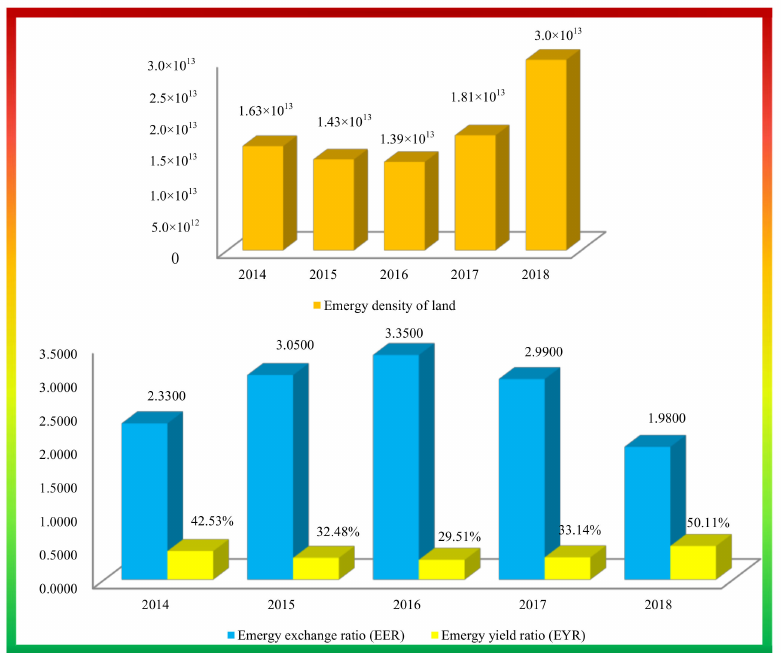
Figure 3. Analysis of system function